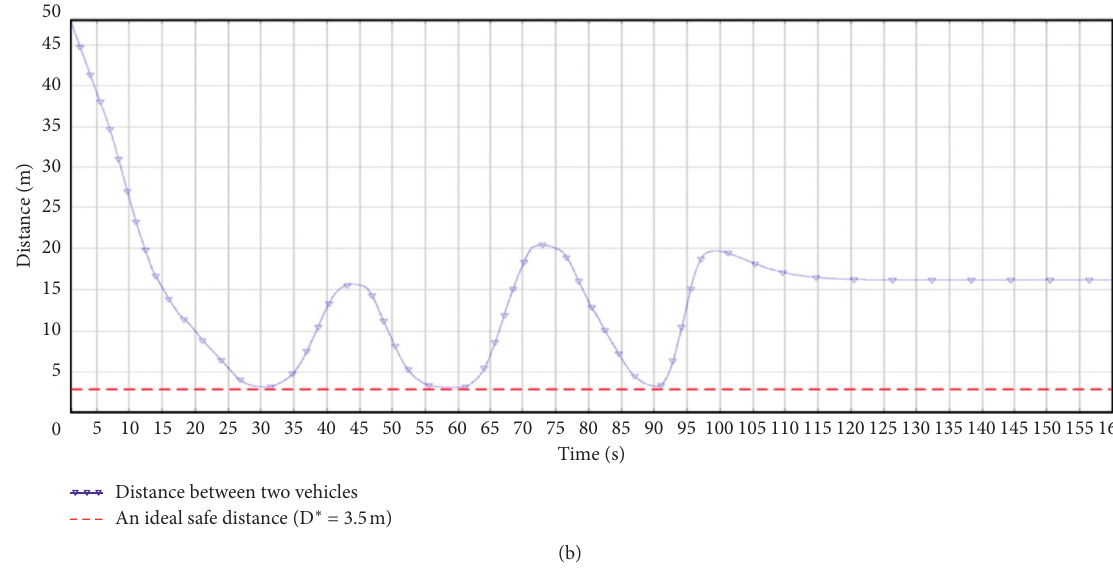
Figure 12: The simulation results for vehicle automatic stop-and-go control. (a) The simulation results for velocity in vehicle stop-and-go scenario. (b) The simulation results for distance in vehicle stop-and-go scenario.